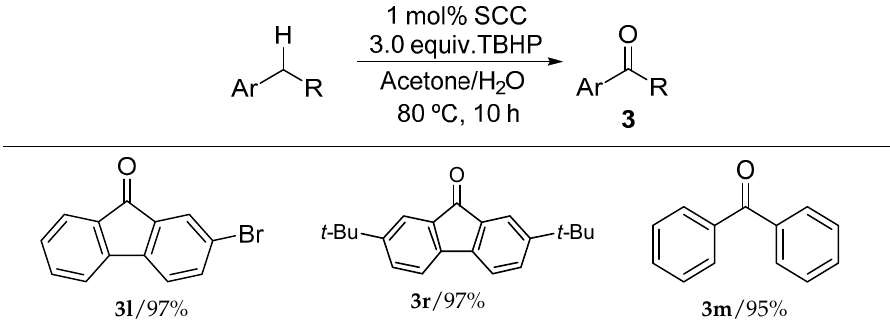
Table 5. The oxidation of diarylmethanes catalyzed by SCC a .